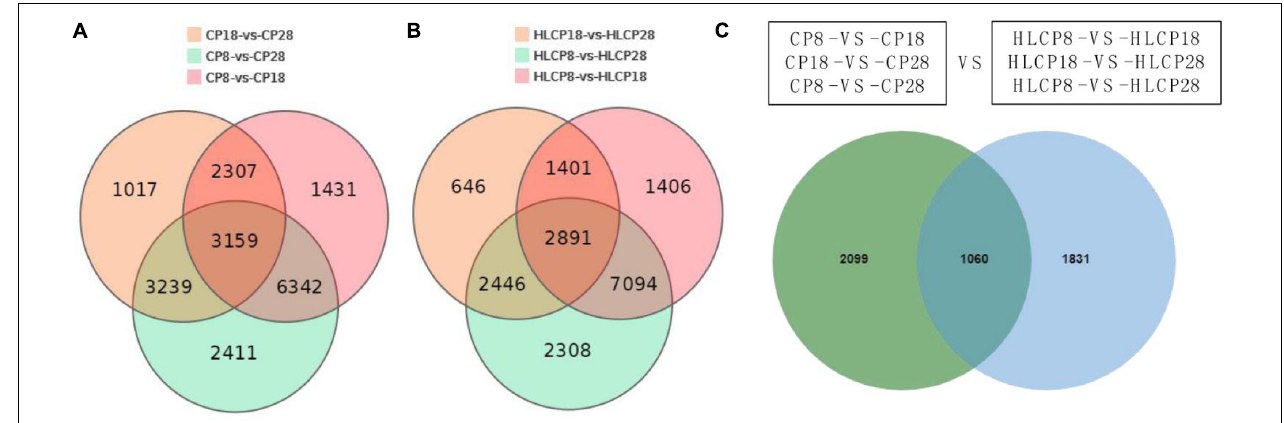
FIGURE 2 | Venn diagram of differentially expression genes (DEGs). (A) DEGs of hulled variety. (B) DEGs of hull-less variety. (C) Venn diagram showing the number of unique DEGs in the two varieties.